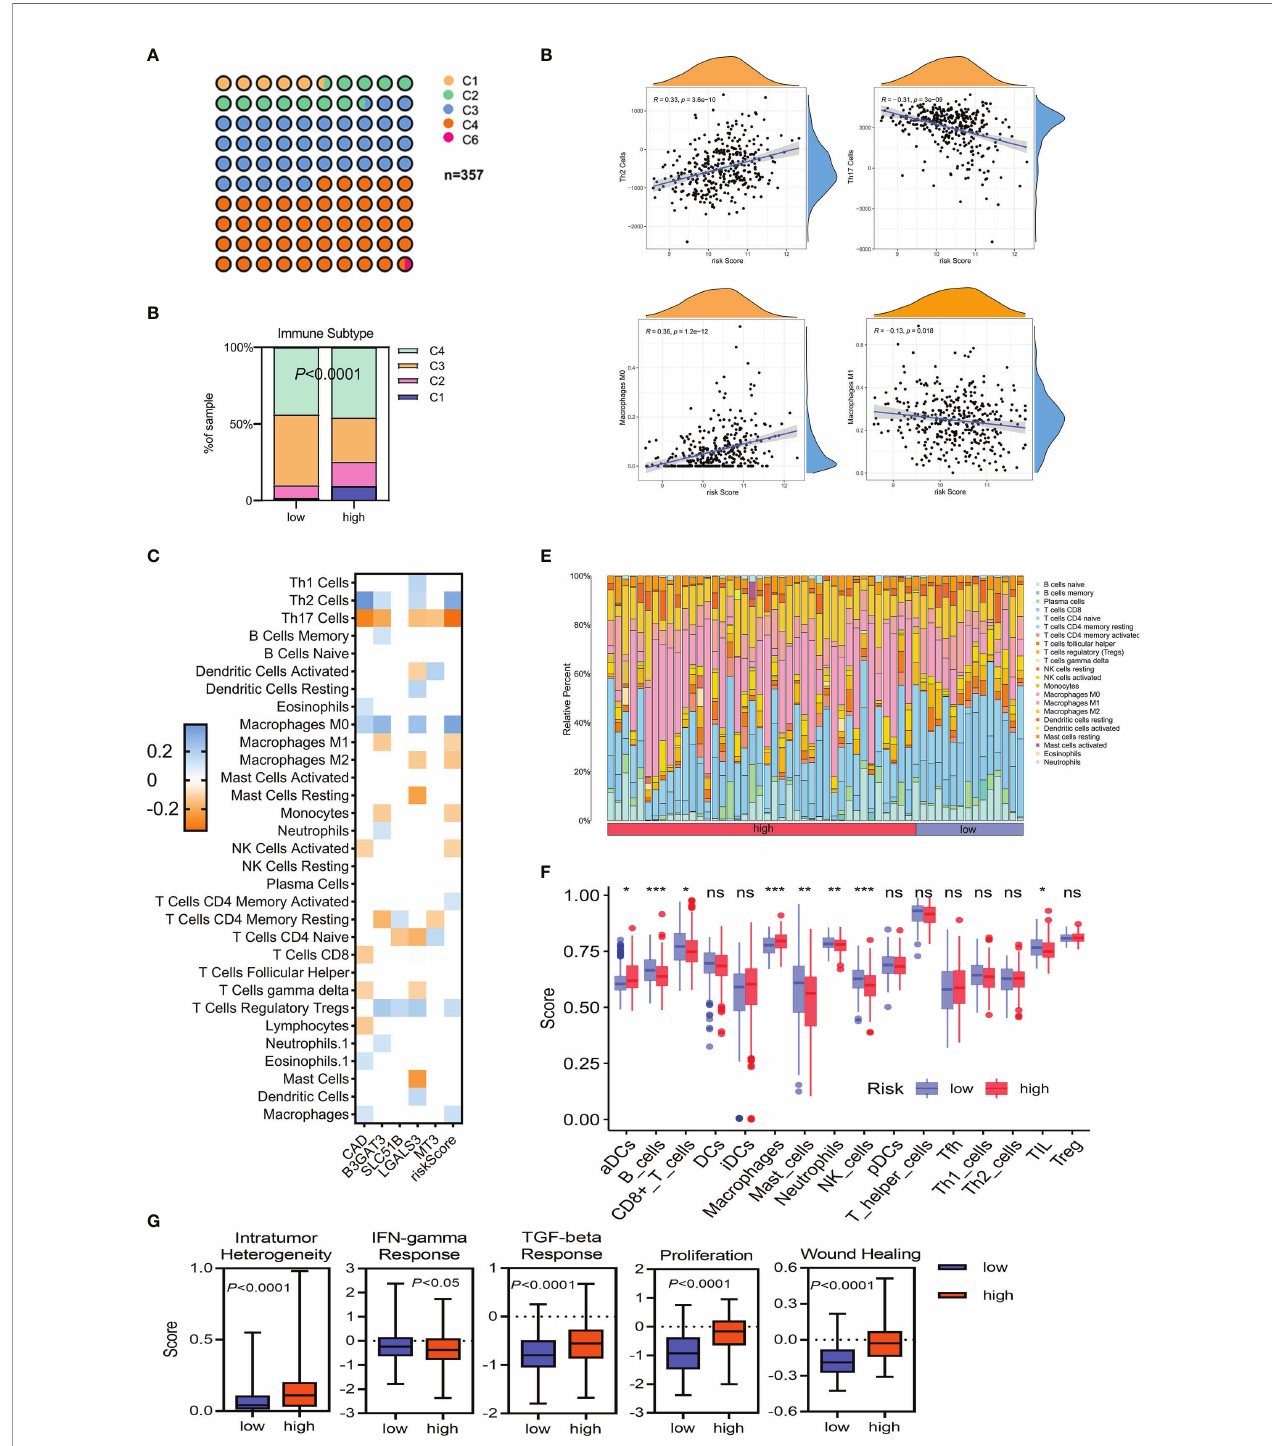
FIGURE 7 | The immune landscape of HCC tumors in TCGA-LIHC. (A, B) Classi fi cation of low- and high-risk HCC tumors into C1 – C6 classes. C1, wound healing; C2, IFN- g dominant; C3, in fl ammatory; C4, lymphocyte depleted; C6, TGF- b dominant. (C) Heatmap of Spearman ’ s correlation between transcriptome pro fi les, risk scores, and immune in fi ltration. Only statistically signi fi cant correlations are shown ( P < 0.05). (D) Spearman ’ s correlation of Th2/Th17 in fi ltration, M0/M1 macrophage in fi ltration, and the glycosylation-based risk score. (E, F) Different relative proportions of immune cells in different groups. (G) Scores of the fi ve distinct immune indices between the low- and high-risk groups. * P < 0.05; ** P < 0.01; *** P < 0.001, ns, not signi fi